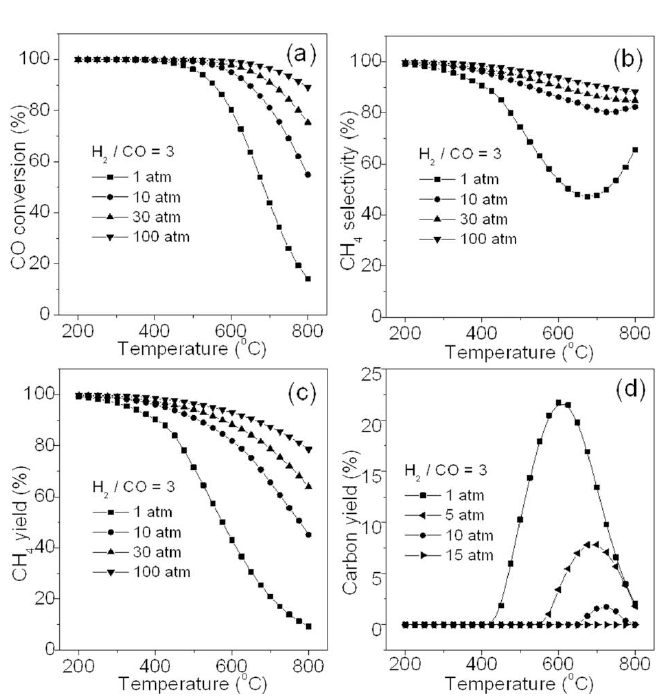
Figure 2. Effects of pressure and temperature on CO conversion ( a ), CH 4 selectivity ( b ) CH 4 yield ( c ), and carbon yield ( d ). Reprinted from [18].